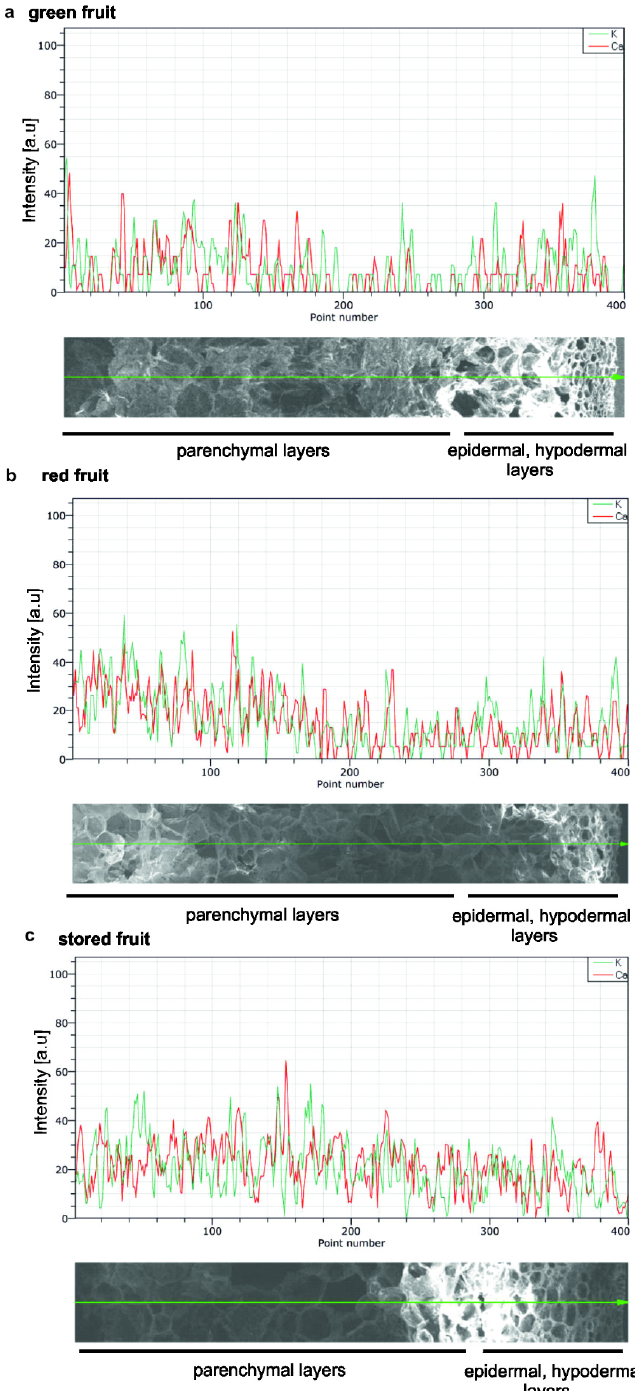
Figure 4. Mapping of calcium and potassium ion distribution in apple fruit at different stages of ripening: green fruit ( a ), red fruit ( b ) and stored fruit ( c ). Studies on Ca content was detected by SEM X-ray line profiles with magnification 100 ×. Red curve, Ca intensity counts. Green curve, K intensity counts. Green line on SEM images, the scanning line.